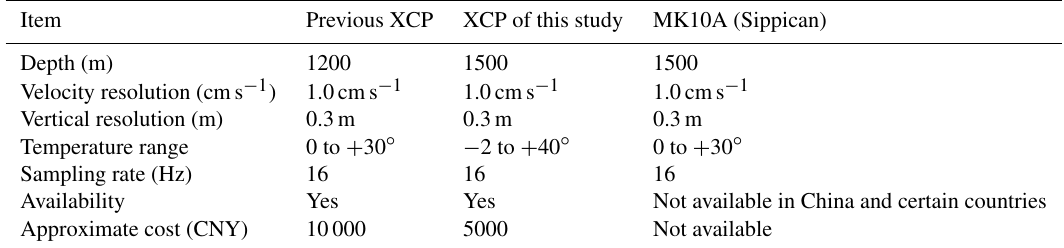
Figure 16. Comparison of electrode voltages measured by the two types of XCPs. Table 4. Comparison of instrument performance indicators.